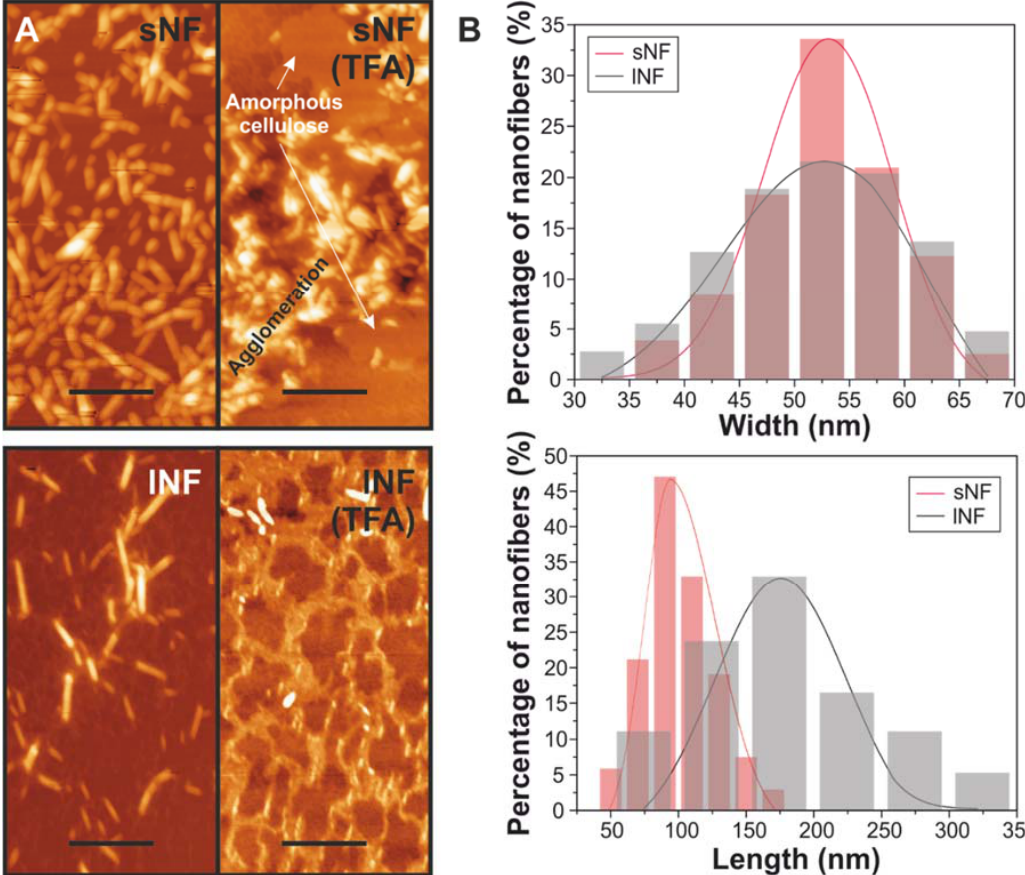
Figure 1. ( A ) Atomic force microscopy (AFM) topographies of short nanofibers (sNF) and long nanofibers (lNF) before and after the solvent treatment. The amorphous domains and agglomerations in the topography of the treated lNF are indicated. Scale bar = 400 nm. ( B ) Histograms showing the width ( top ) and length ( bottom ) distributions of the cellulose nanofibers: sNF (red), lNF (black).